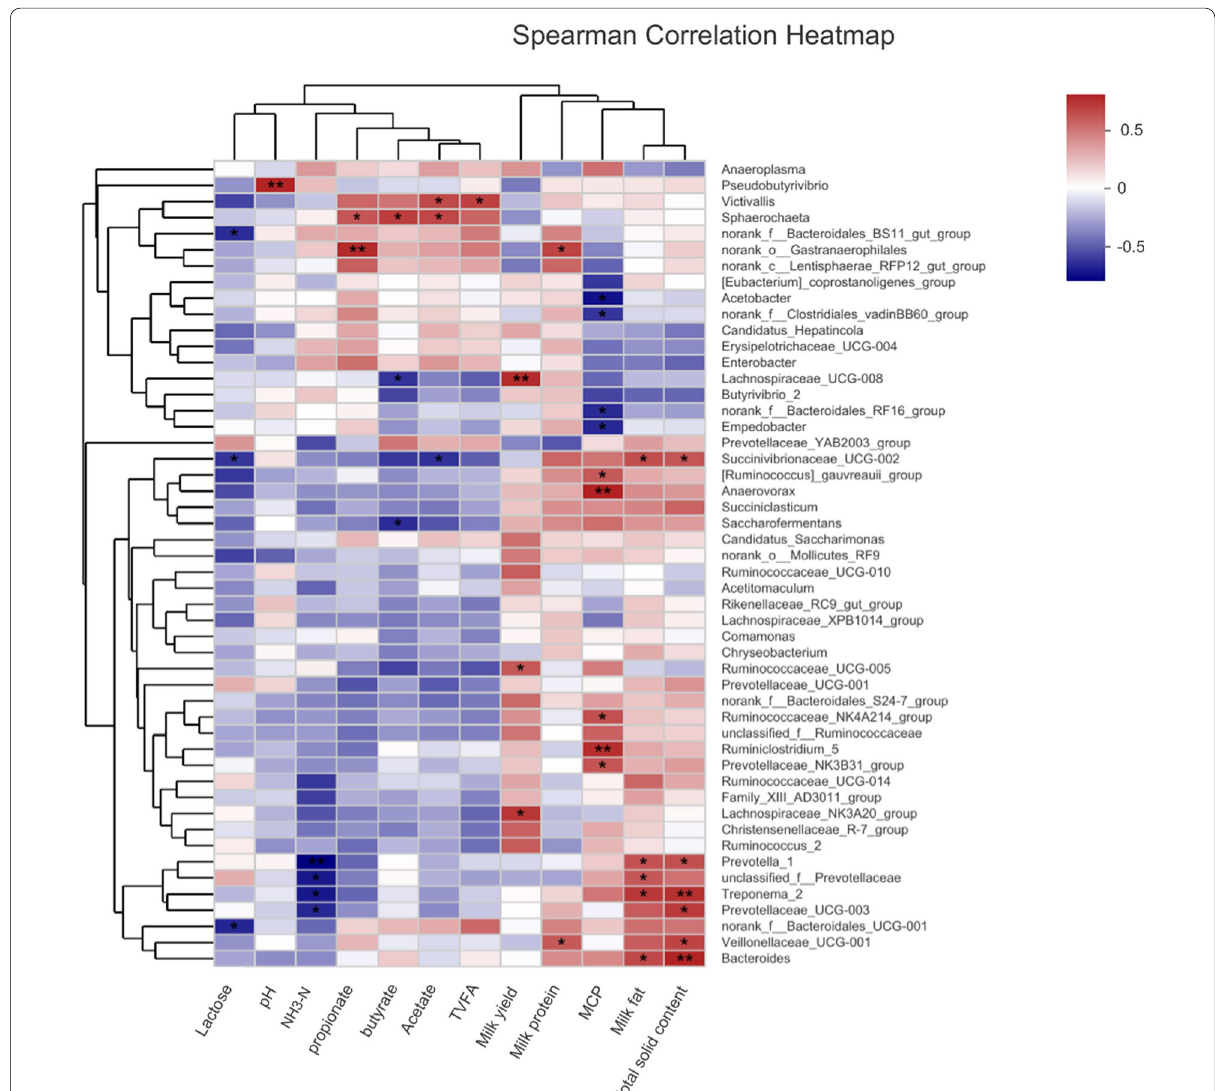
Fig. 3 Correlation of bacterial genera with pH, VFA, milk composition, milk yield, NH 3 –N and